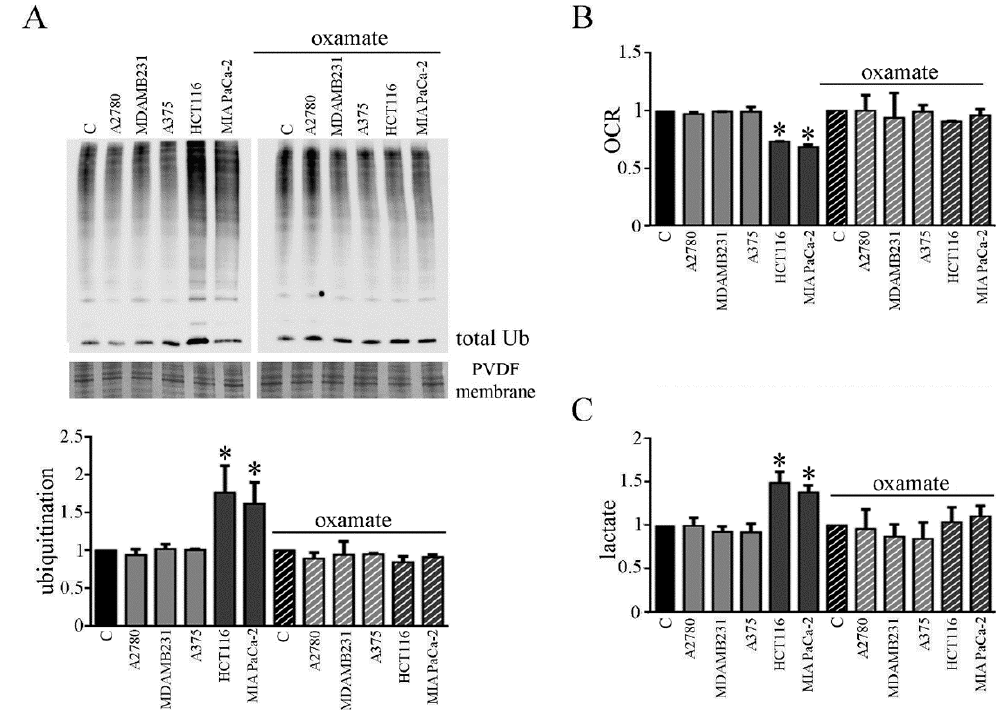
Figure 7. LDH inhibition in myotubes treated with CM from colon and pancreatic human carcinoma cell lines prevents induction of cachexia. CMs were obtained by cultivating human carcinoma cells not-inducing cachexia in vivo (breast carcinoma MDAMB231, melanoma A375, ovarian A2780) and human carcinoma cells inducing cachexia in vivo (colon carcinoma HCT116, pancreatic carcinoma MIAPaCa-2). Four-day-differentiated myotubes were treated with CMs for 24 h. Untreated myotubes (indicated with C) were maintained in differentiating medium for the same period. Where indicated, LDH inhibitor’s oxamate (75 mM final) was added to media. ( A ) Ubiquitination level in myotubes treated with different media with or without oxamate. Bar graph shows total ubiquitination level obtained by using Coomassie-stained PVDF membrane for normalization. ( B ) Oxygen consumption rate (OCR) analysis in treated myotubes with or without oxamate. ( C ) Assay of lactate in the media of CM-treated myotubes with or without oxamate. All the values in the bar graphs were reported as fold increase, considering control myotubes as 1; n = 3; * p < 0.05.